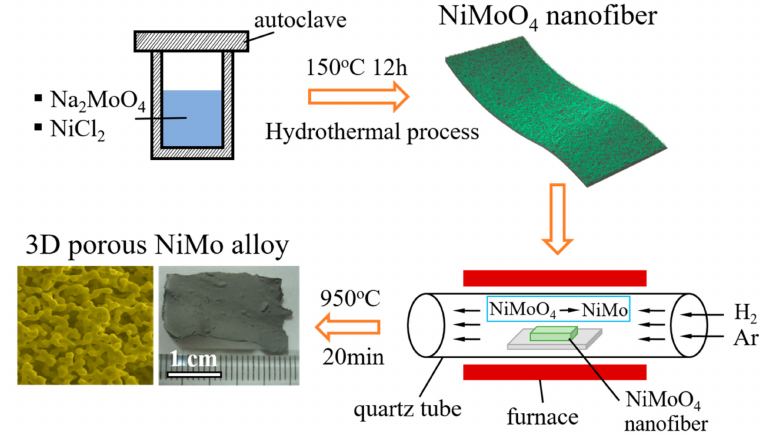
Figure 1. Schematic illustration of the synthesis process of 3D porous NiMo